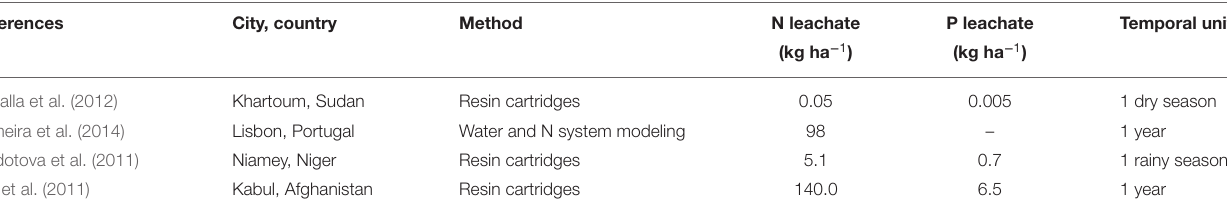
TABLE 4 | Average nutrient losses found in studies that quantified leachate in real-world UA (non-controlled) settings.